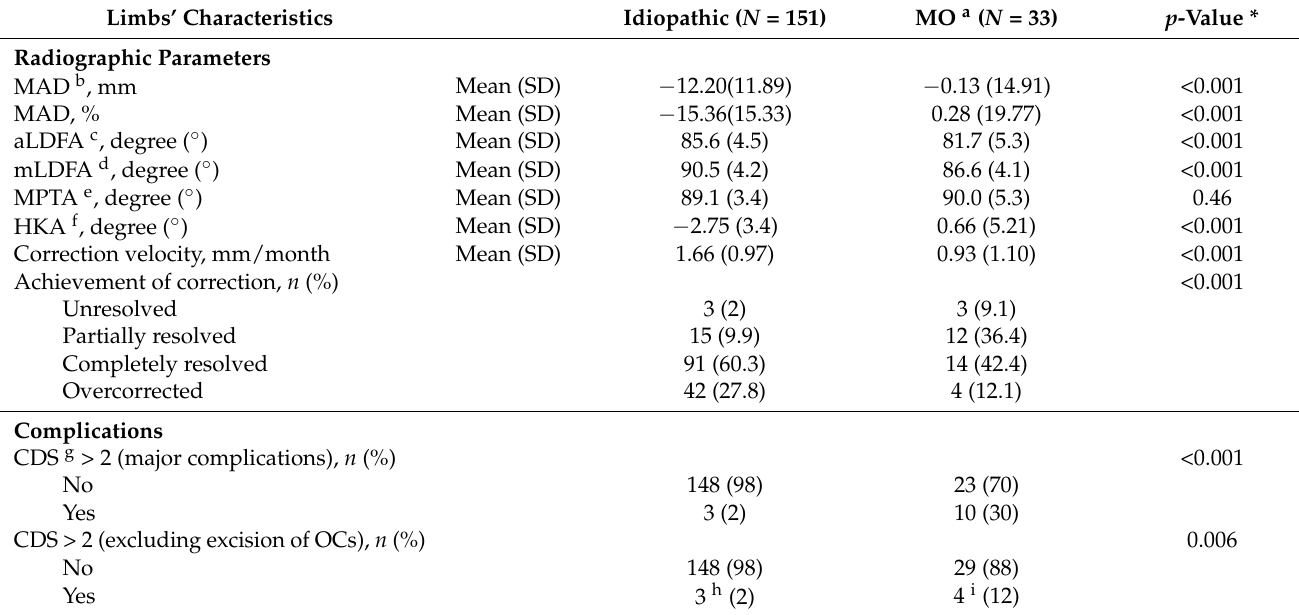
Table 3. Limbs’ characteristics at postoperative